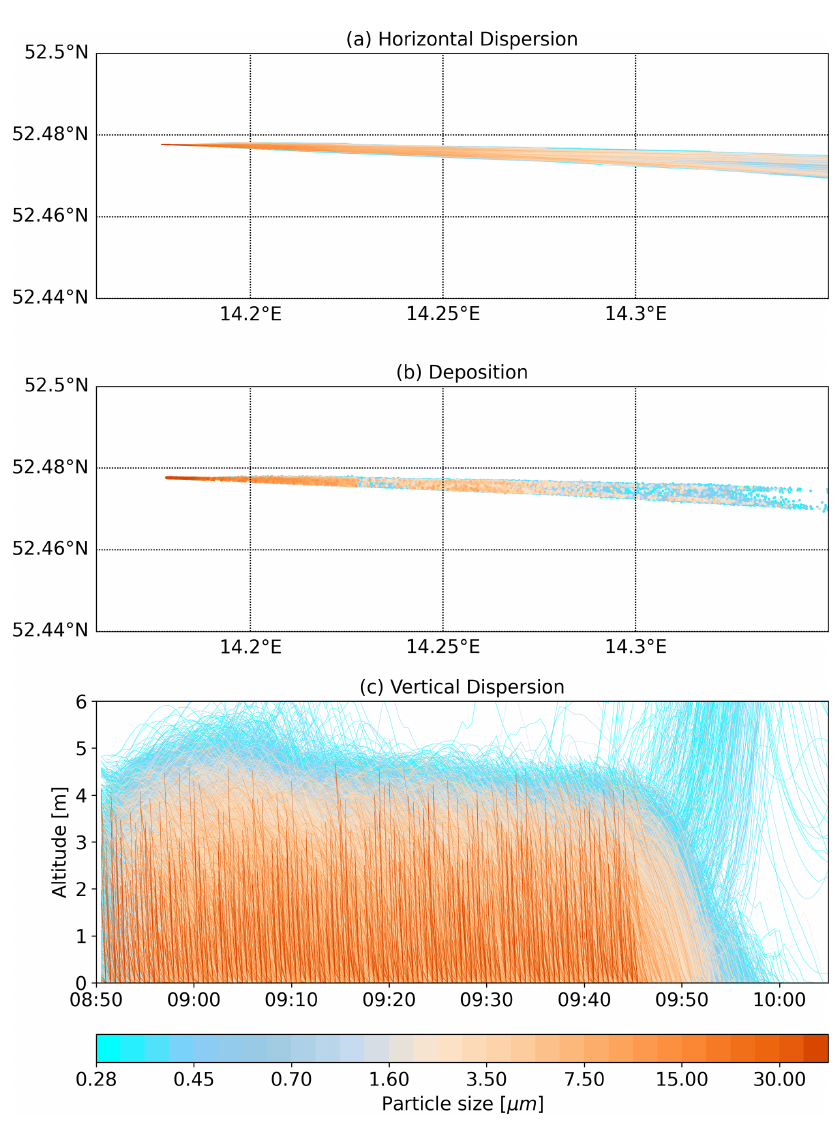
Figure 4. Particle motion of EXP1: (a) horizontal trajectories, (b) deposition points, (c) vertical trajectories.